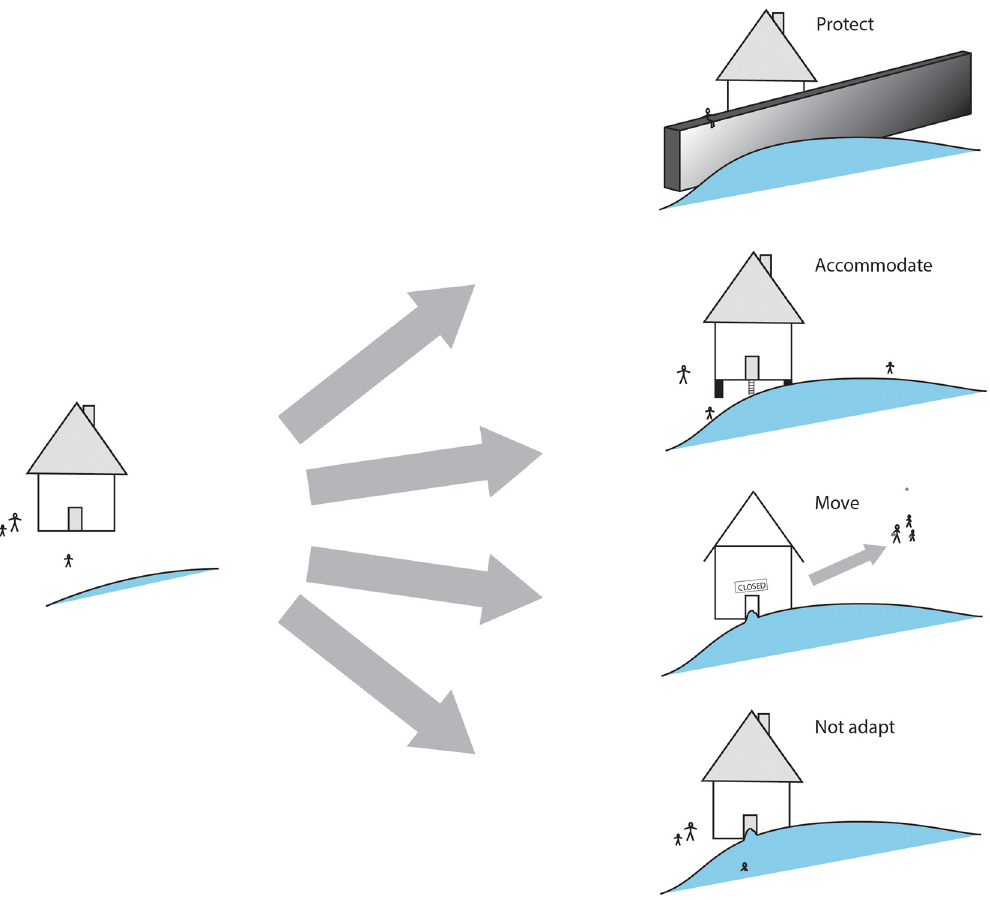
Figure 2: In general, people choose one or more of four strategies when they adapt to changing sea levels – they protect, accommodate, they leave the area, or continue their activities without any form of adaptation. Illustration: Axel Mjærum, Museum of Cultural